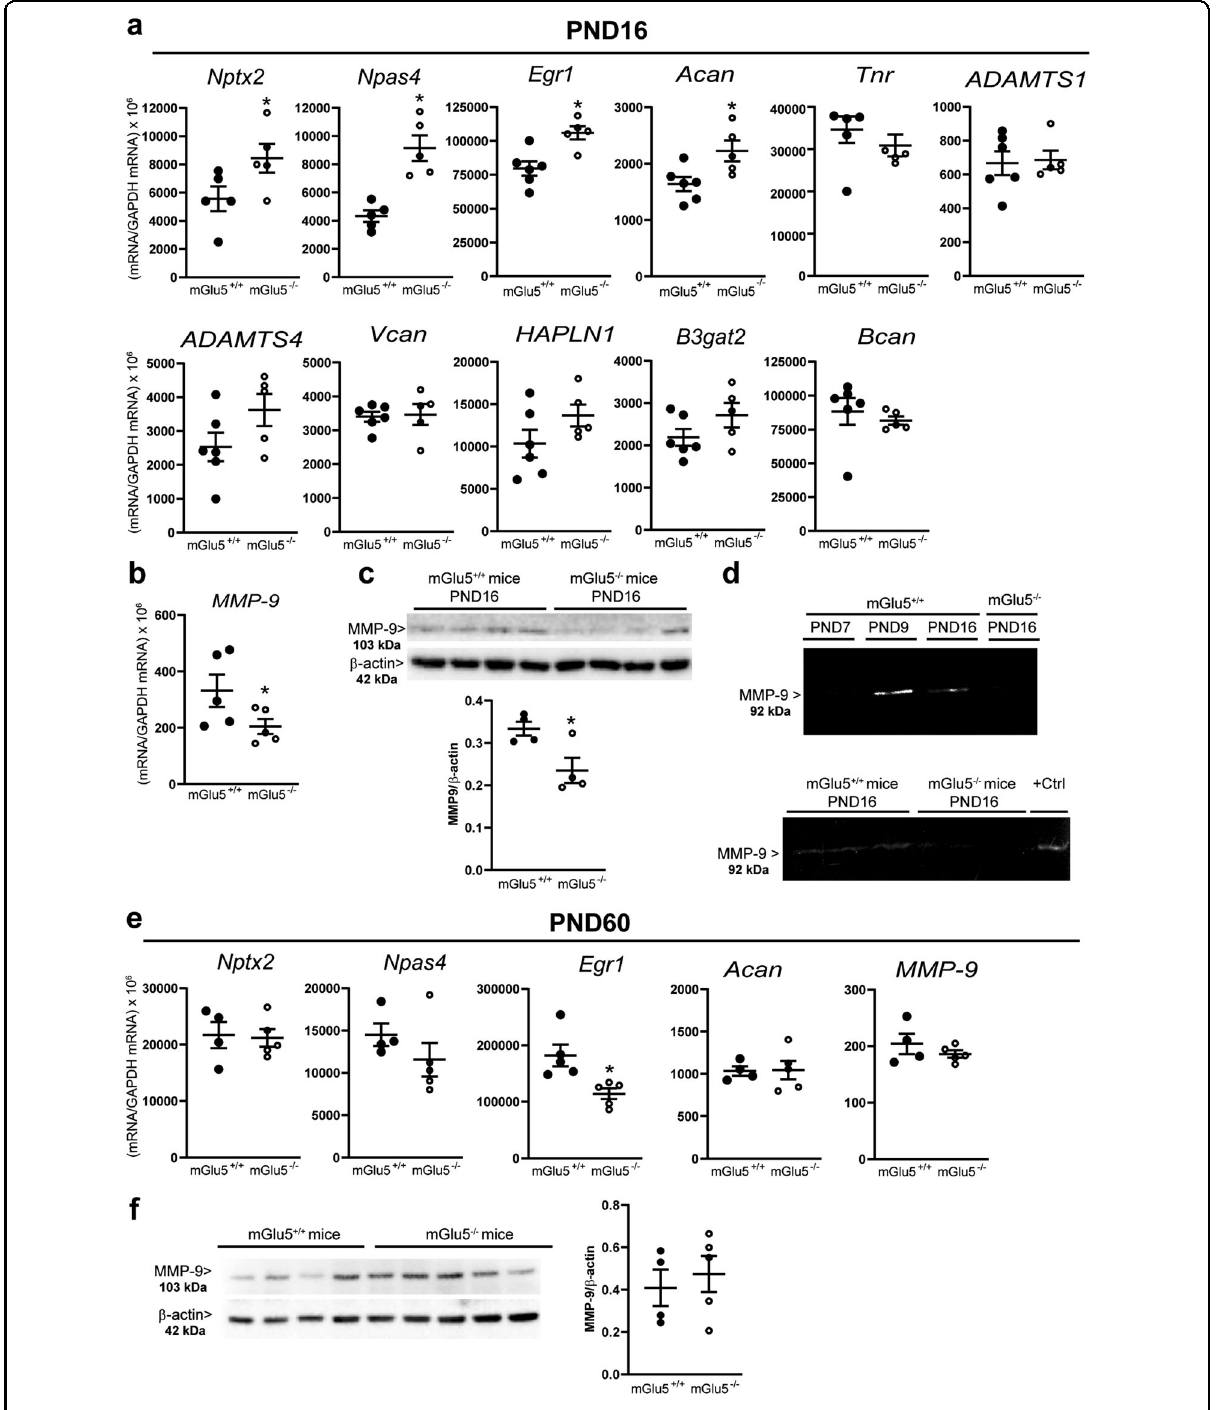
Fig. 4 Expression of genes and proteins involved in the formation or degradation of PNNs in the somatosensory cortex of mGlu5 + / + and mGlu5 − / − mice at PND16 and PND60. a mRNA levels (copy numbers normalized by GAPDH) *Statistically signi fi cant vs. mGlu5 + / + (Student ’ s t test); Nptx2, t8 = − 2.15; p = 0/03; NPAS4, t8 = − 4.87; p = 0.0012; Egr1, t9 = − 3.63; p = 0.005; Acan, t9 = − 2.73; p = 0.02. b , c MMP-9 mRNA and protein levels. *Statistically signi fi cant vs. mGlu5 + / + (Student ’ s t test); b t8 = − 2.08; p = 0.03; c t6 = 2.905; p = 0.027. d Gelatin zymography of MMP-9 activity. e mRNA levels of Nptx2, NPAS4, Egr-1, Acan, and MMP-9 in the somatosensory cortex of the two genotypes at PND60. *Statistically signi fi cant vs. mGlu5 + / + (Student ’ s t test); t8 = 3,162; p < 0.05; f Immunoblot of MMP-9 in the somatosensory cortex at